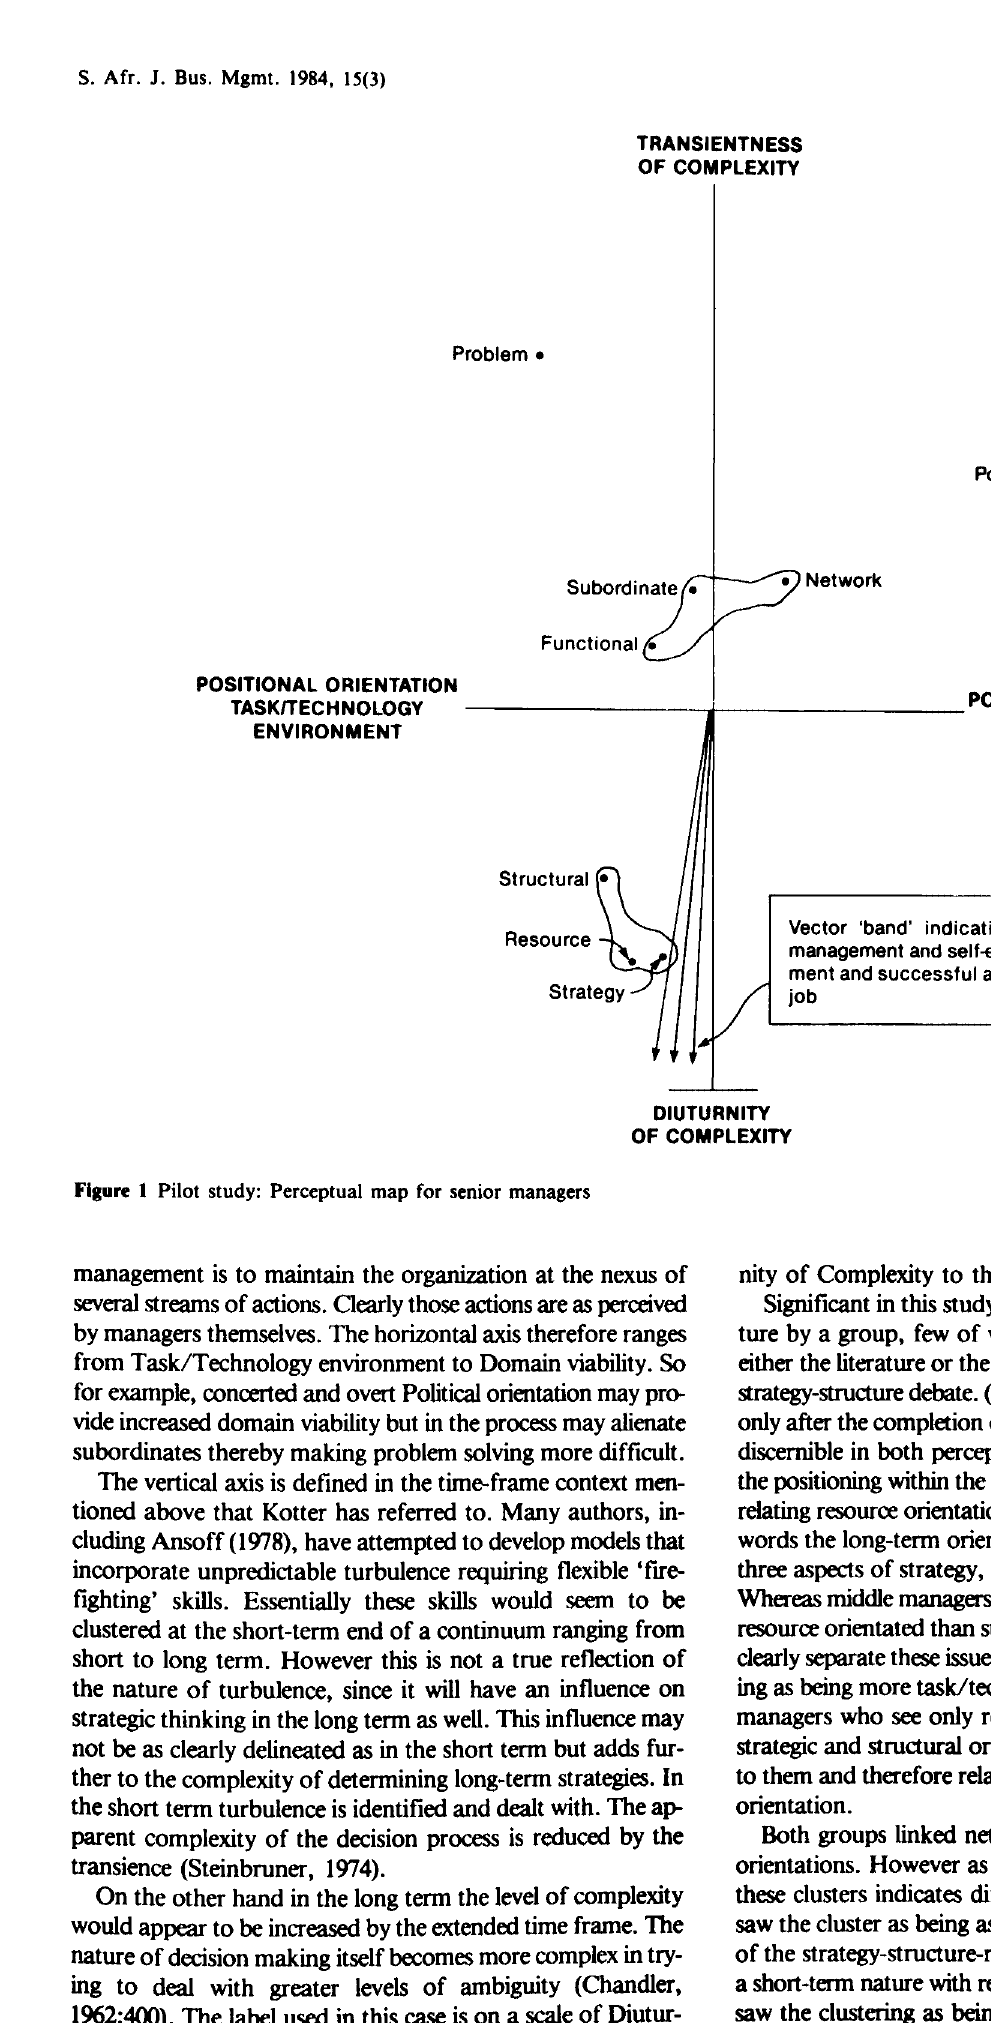
management is to maintain the organiz.ation at the nexus of several streams of actions. Oearly those actions are as perceived by managers themselves. The horizontal axis therefore ranges from Task/Technology environment to Domain viability. So for example, concerted and overt Political orientation may pro vide increased domain viability but in the process may alienate subordinates thereby making problem solving more